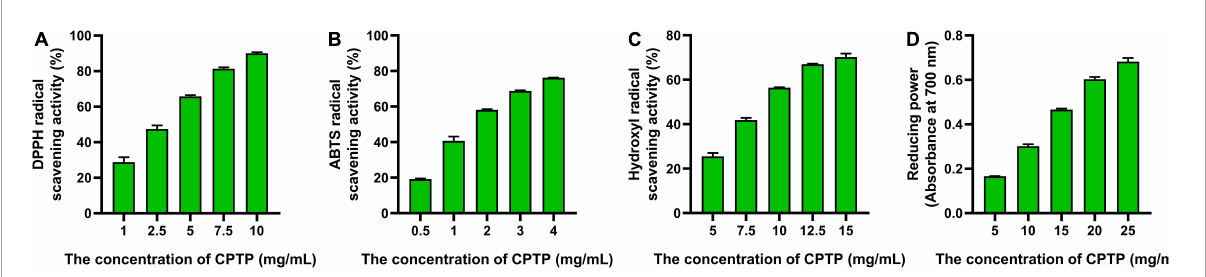
FIGURE1 Antioxidant activities of Chinese pond turtle peptide (CPTP) in vitro . Radical scavenging activity of (A) 1,1-diphenyl-2-pycryl-hydrazyl (DPPH); (B) 2,2-azinobis (3-ethylbenzothiazo-line-6-sulfonic acid) diammonium salt (ABTS); (C) Hydroxyl; (D) Reducing power. The data are presented as mean ± SEM.